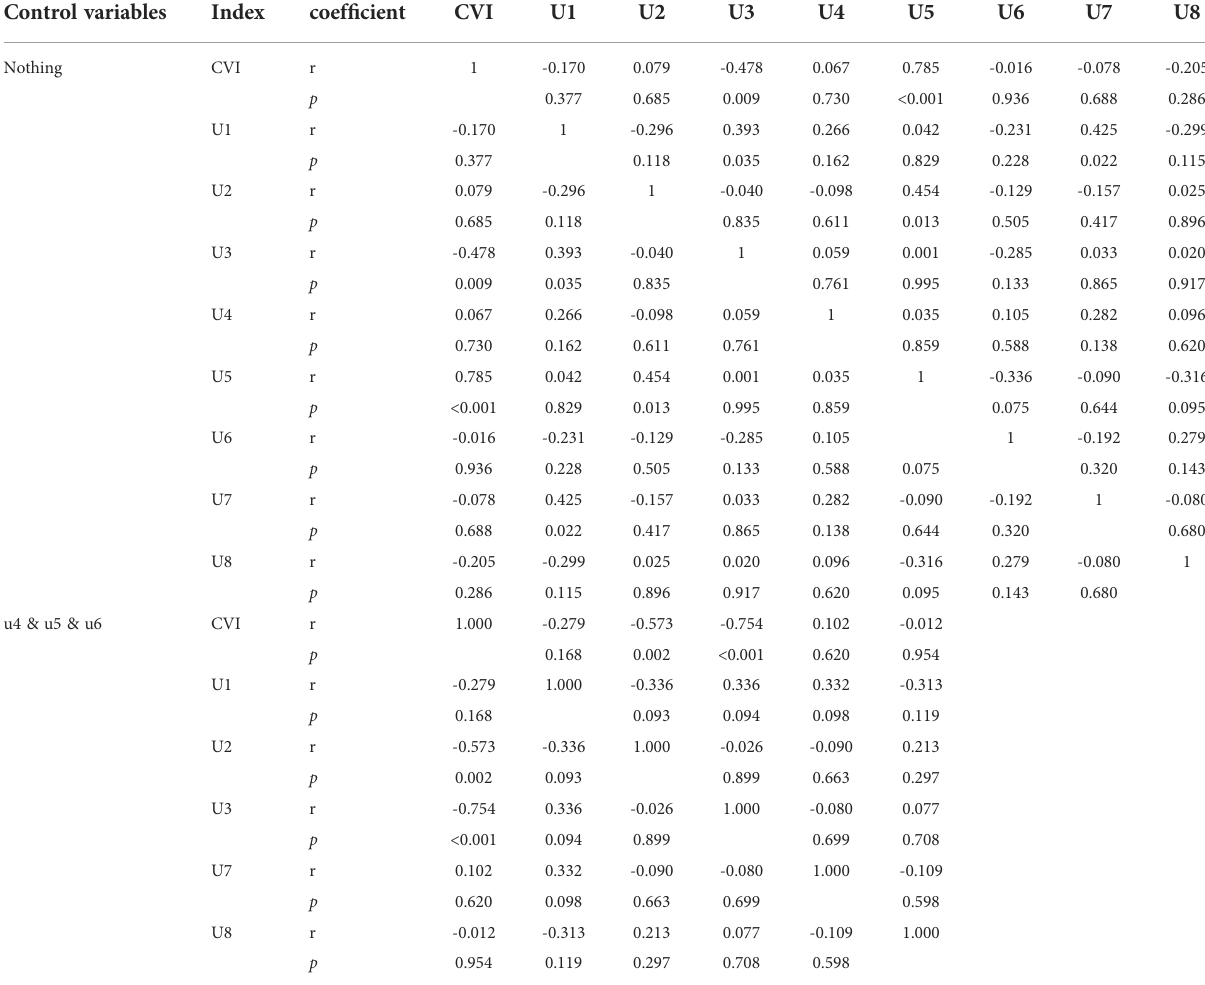
TABLE 3 Correlation between CVI and each evaluation factor based on Spearson method. Control